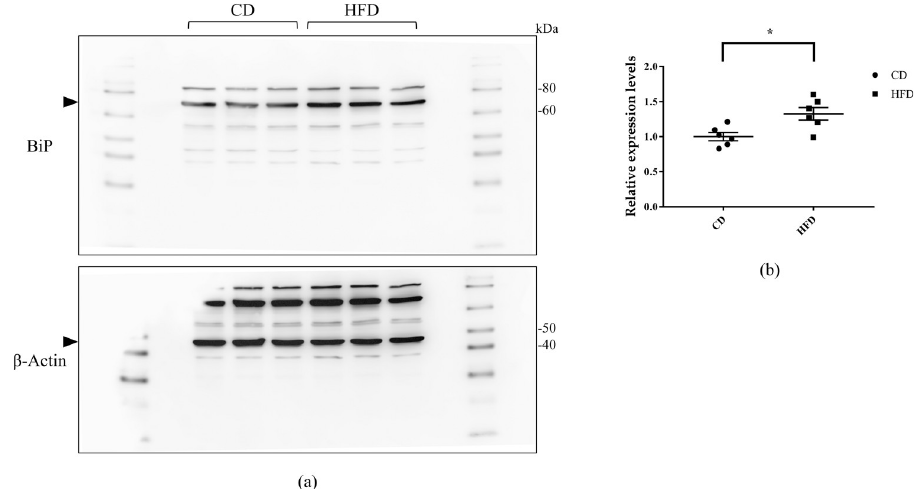
Fig 6. Western blot analysis. (a) Representative images of immunoblots for BiP in C57BL6/J mouse renal tissue homogenates. (b) Quantification of the signal intensities, expressed relative to the control group. β -actin is the loading control. Bars indicate mean ± SEM. � p < 0.05 (unpaired t-test). n = 6 each group. CD, control diet group; HFD, high- fat diet group.